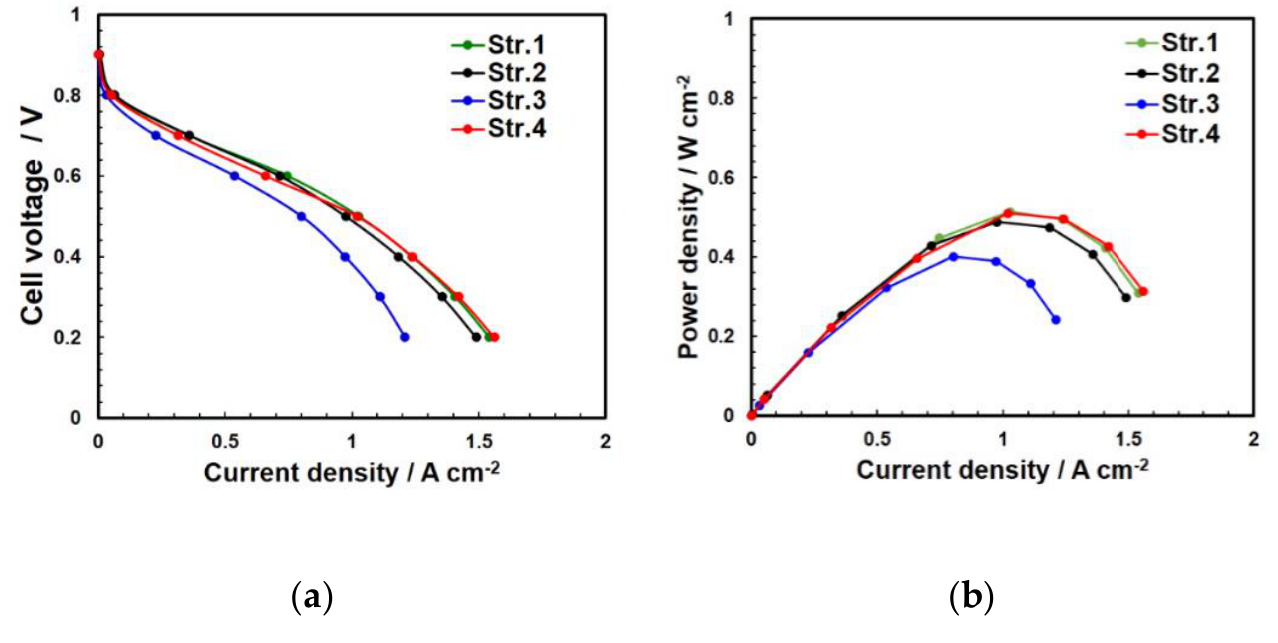
Figure 6. ( a ) Polarization curves and ( b ) power densities of the four samples at 100% RH.